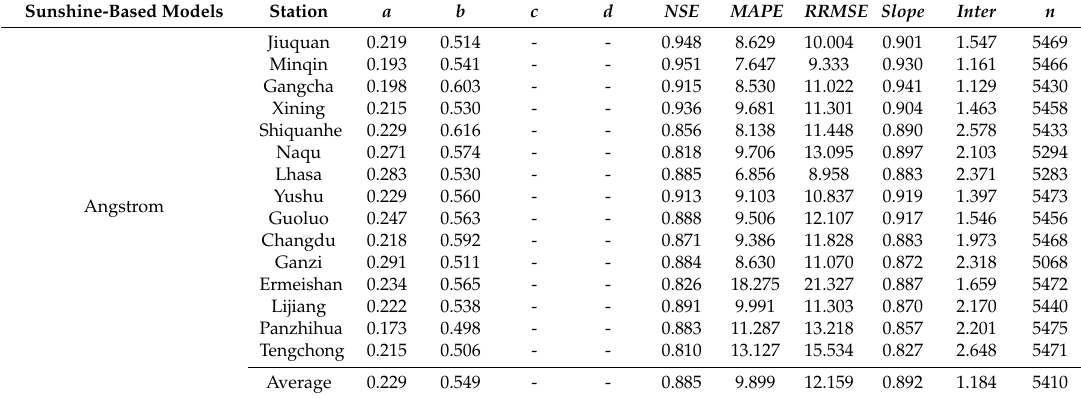
Table 1. Calibration of the sunshine- and temperature-based site-dependent models at different locations using data from 1993 to 2007 in this